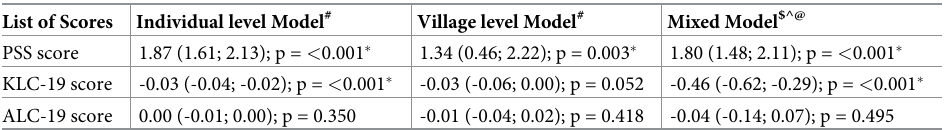
Table 4. Effect of wave 2 FIES score on PSS, KLC-19 and ALC-19